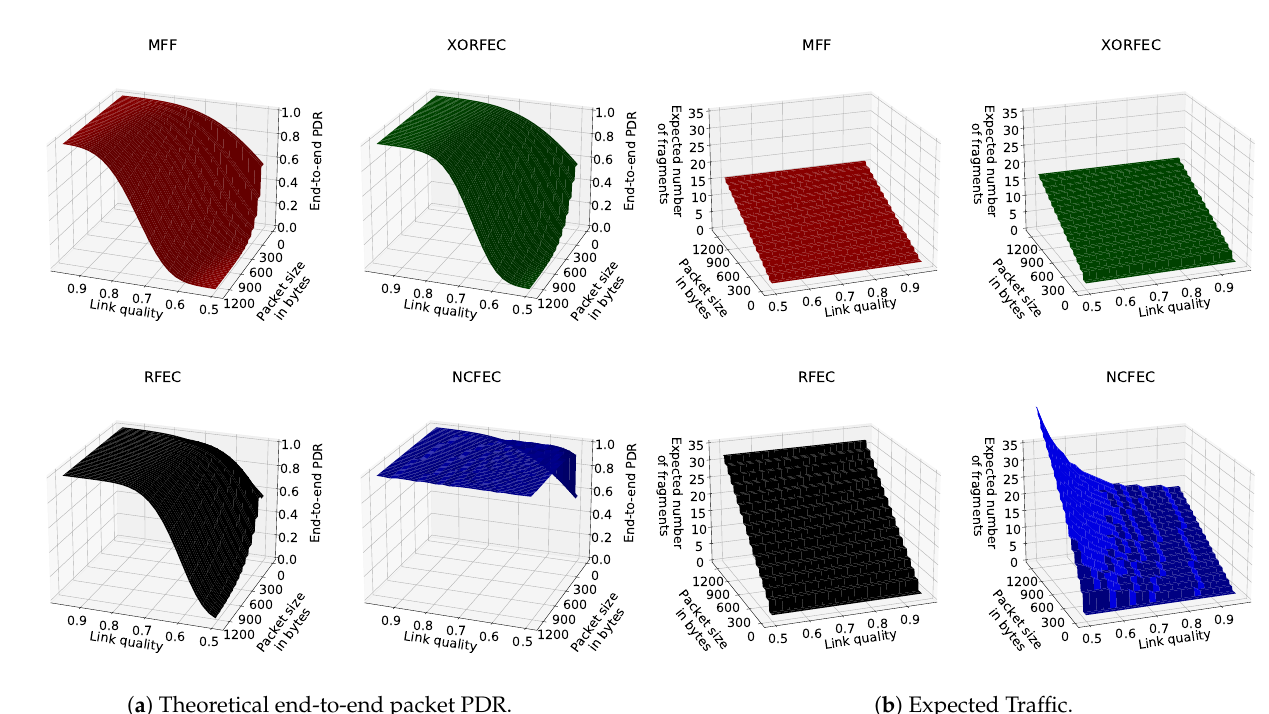
Figure 14. Theoretical performance.